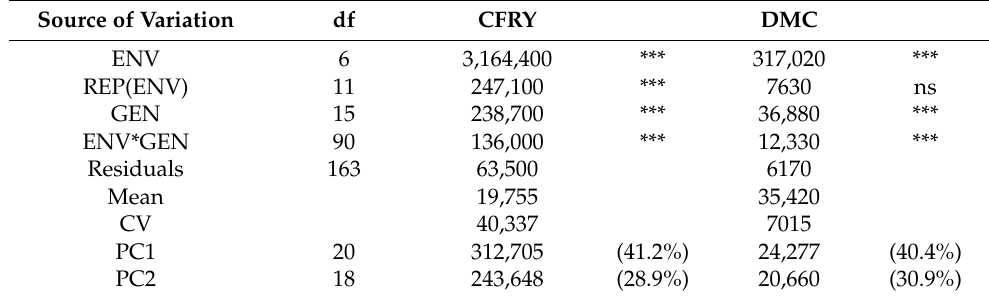
Table 6. Mean squares and significance of commercial root yield (CFRY) and dry matter content (DMC) according to the AMMI